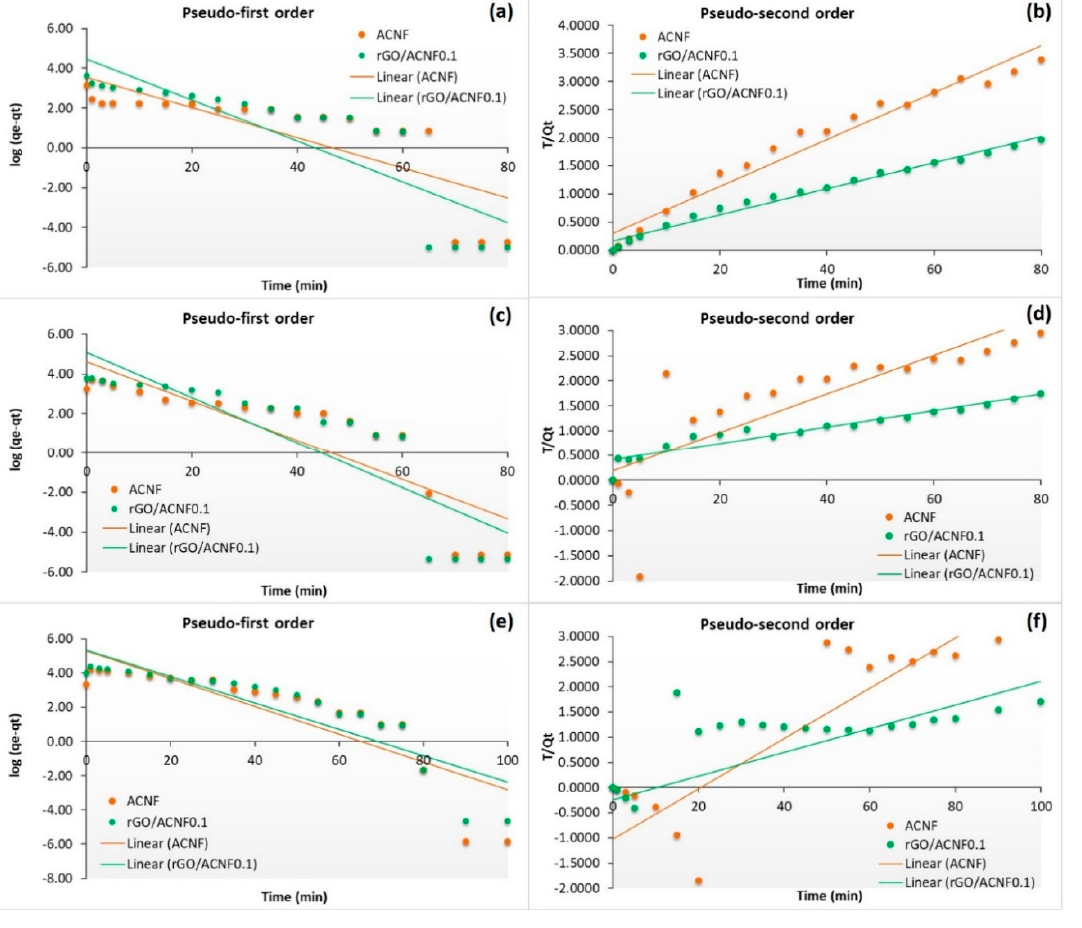
Figure 9. Pseudo-first order and pseudo-second order kinetic models of ACNF and rGO/ACNF0.1 composite at different pressures: ( a , b ) 5 bar, ( c , d ) 10 bar, and ( e , f ) 15 bar.